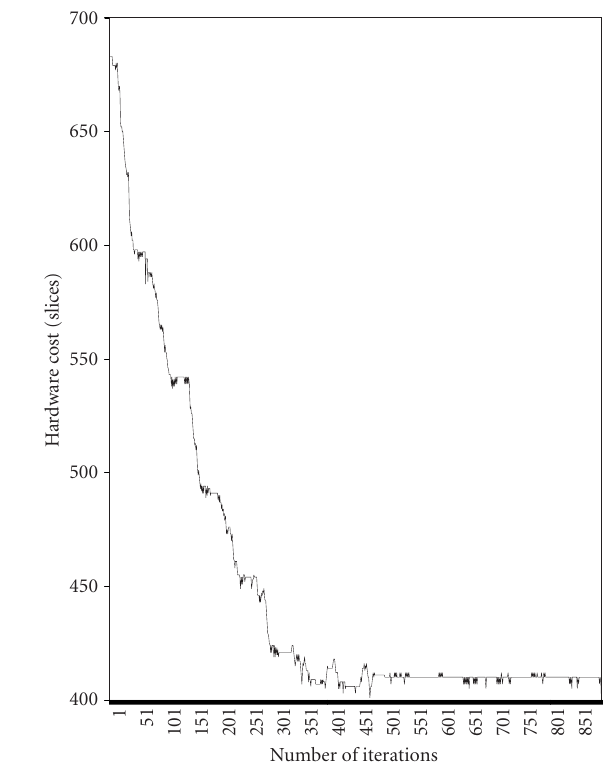
Figure 8: The hardware cost during the design of a DCT approxi- mation as measured using the local estimator (equation (26)). Figure 9: The hardware cost during the design of a DCT approxi- mation as measured using the PAR at each